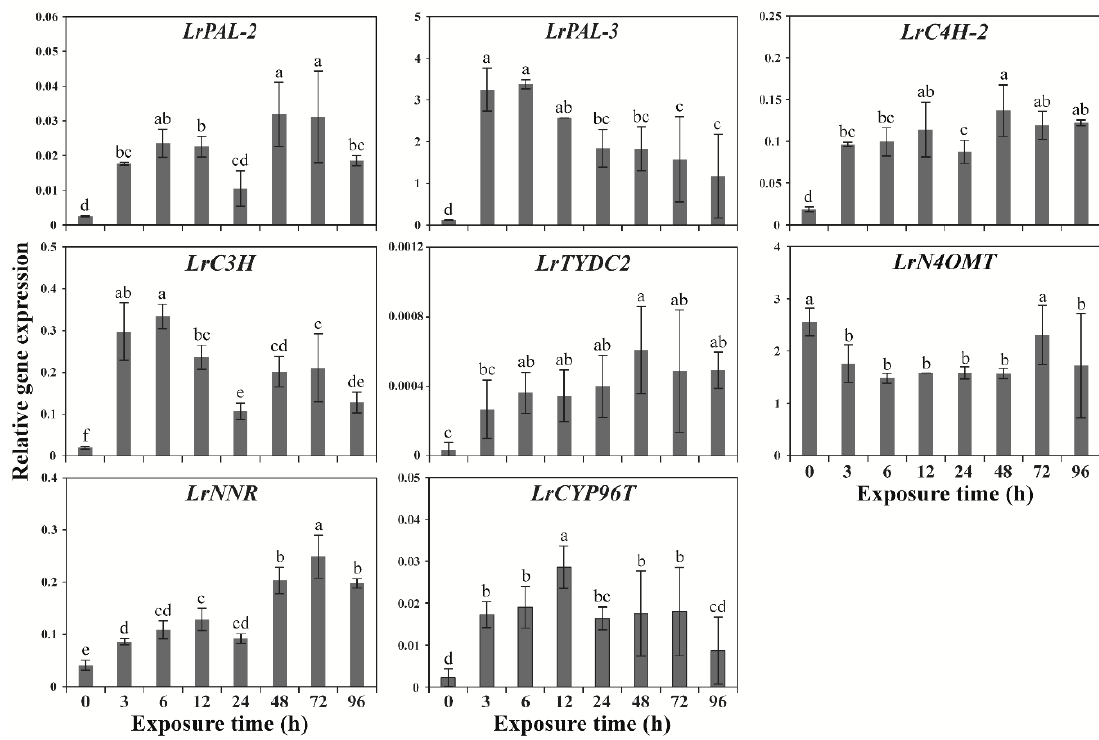
Figure 2. Relative gene expression levels of galantamine pathway genes at different time points following exposure to wounding stress. The housing keeping gene β -actin was used as internal control. Results are given as the mean of triplicates ± SD. Different letters indicate significant differences at p < 0.05.